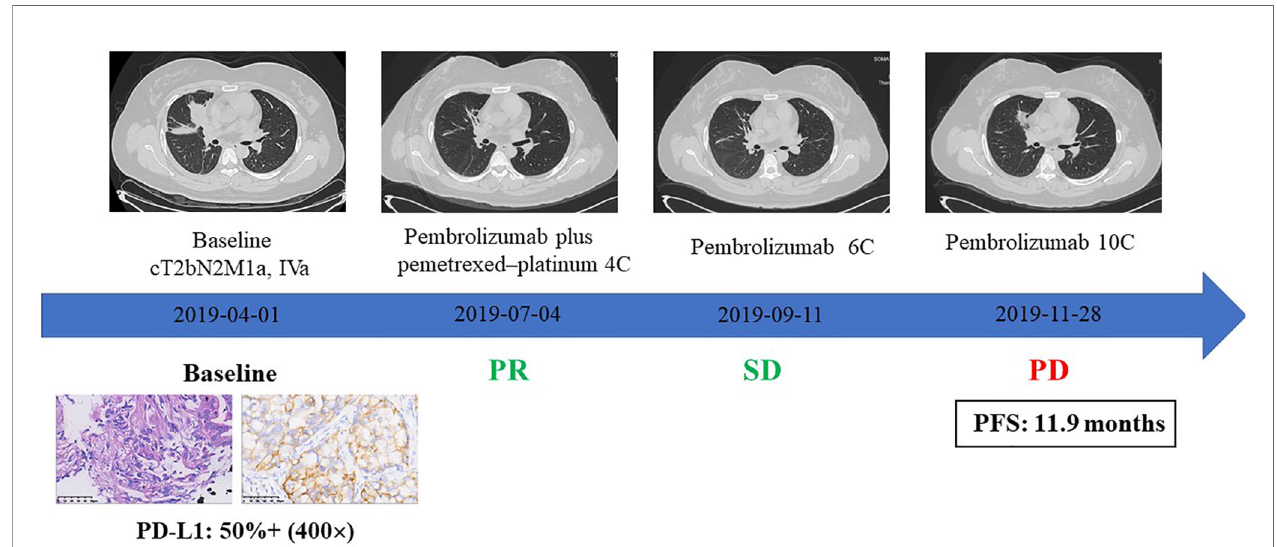
FIGURE 4 | The clinical response to immune checkpoint inhibitors combined with chemotherapy in an IMA patient with PD-L1 expression and CD8+ TIL in fi